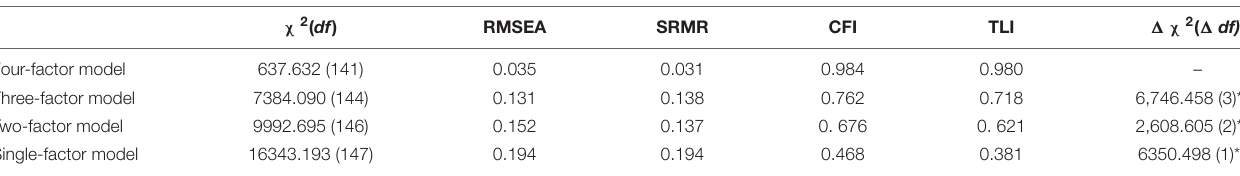
TABLE 4 | Fit indices of the factor